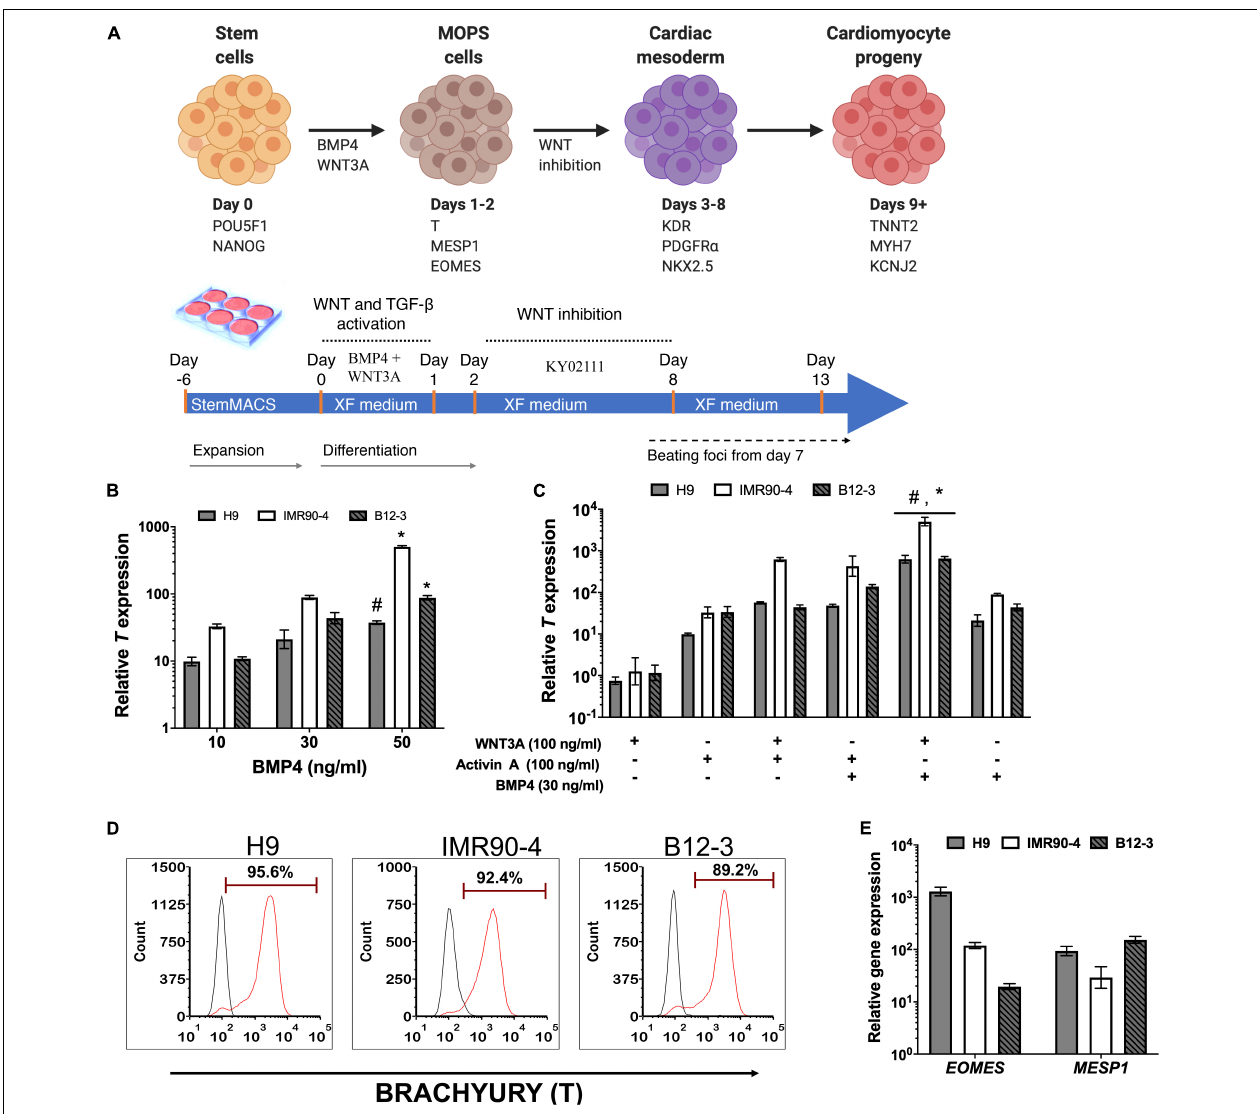
FIGURE 1 | (A) Schematic representation of the differentiation stages and process in planar cultures. (B) Quantitative PCR (qPCR) for T expression at 24 h after treatment of hPSCs with different concentrations of BMP4. # p < 0.05, * p < 0.01 vs. treatment with lower BMP4 concentrations for the respective hPSC lines. (C) qPCR for T expression at 24 h after treatment with different ligand combinations. * p < 0.05 for BMP4 + WNT3A treatment vs. WNT3A only treatment; # p < 0.05 for WNT3A + BMP4 treatment vs. BMP4 only treatment ( Figure 2B ). (D) Representative flow cytometry plots for T expression by cells derived from the differentiation of H9 (91.1 ± 1.4%), IMR90 (83.51 ± 9.72%), and B12-3 (84.43 ± 10.59%) hPSCs. Black curves: isotype control. Results are mean ± SD from at least three independent experiments. (E) Relative expression of early mesoderm genes after BMP4 (30 ng/ml) and Wnt3A (100 ng/ml) treatment of hPSCs for 24